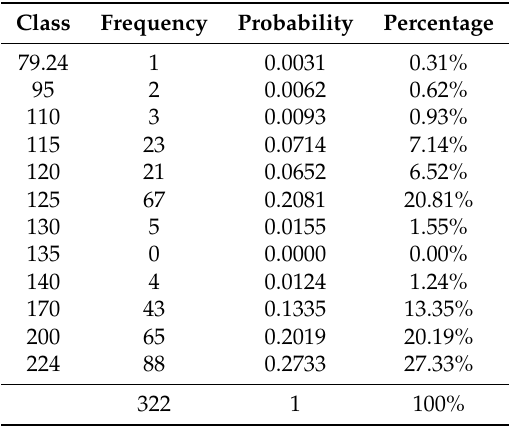
Table 3. Frequency distribution